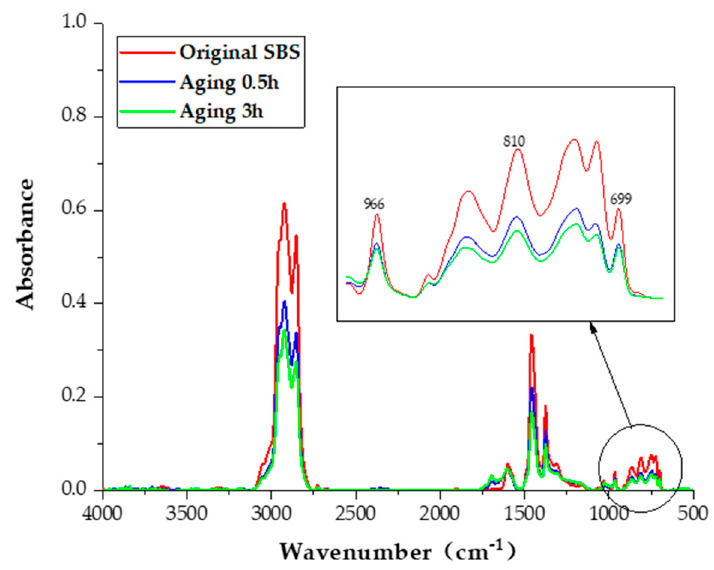
Figure 5. Super-heat aging of SBS in the FTIR test.